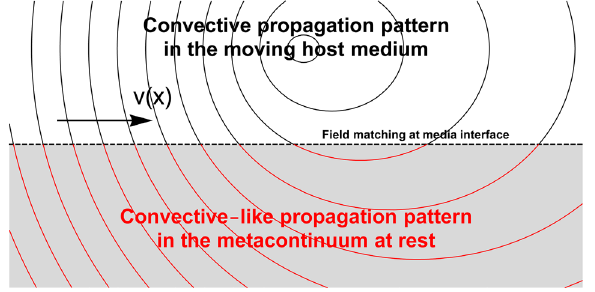
Figure 2. Pictorial representation of the matching of the propagation pattern at the interface between the moving hosting medium and the metafluid at